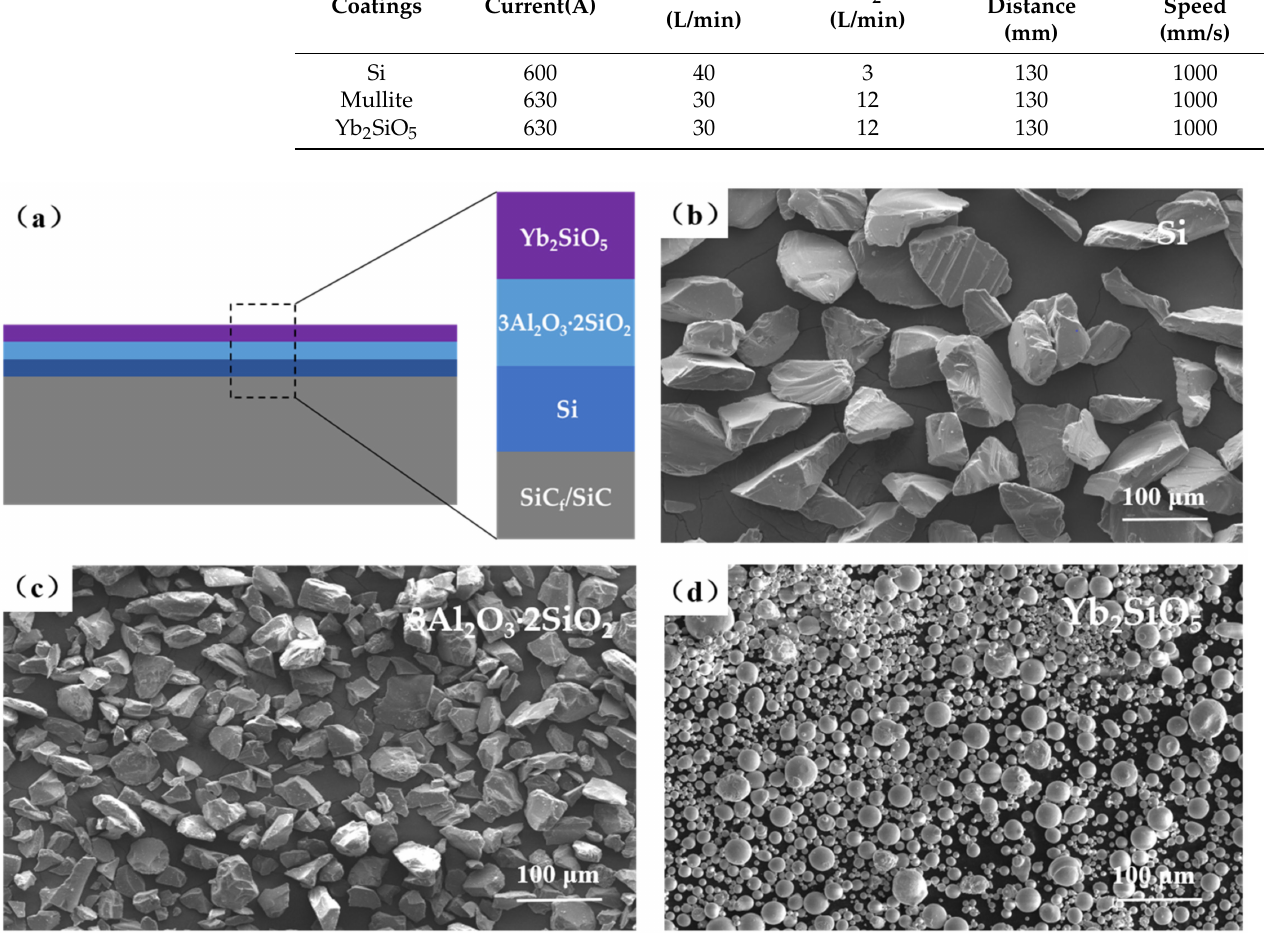
Figure 1. Preparation of the EBC by the PS-PVD thermal spraying process. ( a ) Schematic diagram of the EBC structure. SEM images of each coating powder in the EBC: ( b ) Si; ( c ) 3Al 2 O 3 2SiO 2 ; and ( d ) Yb 2 SiO 5